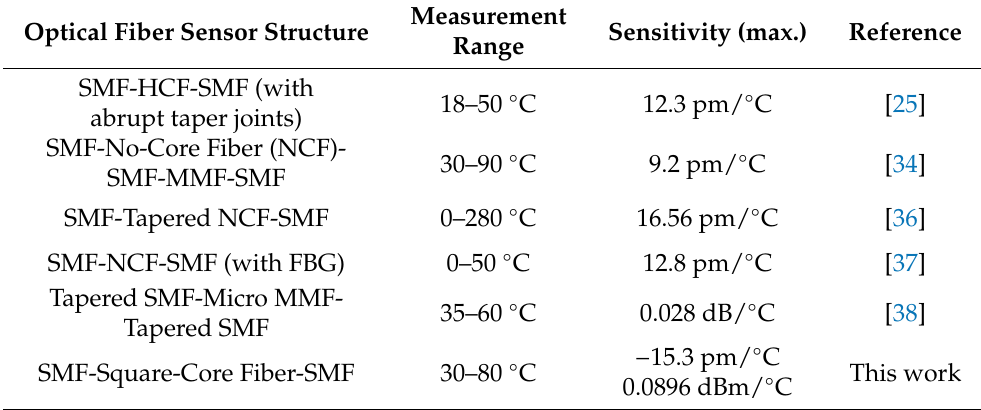
Table 1. Comparison of temperature sensitivities with other multimode-interference-based optical fiber sensors using specialty